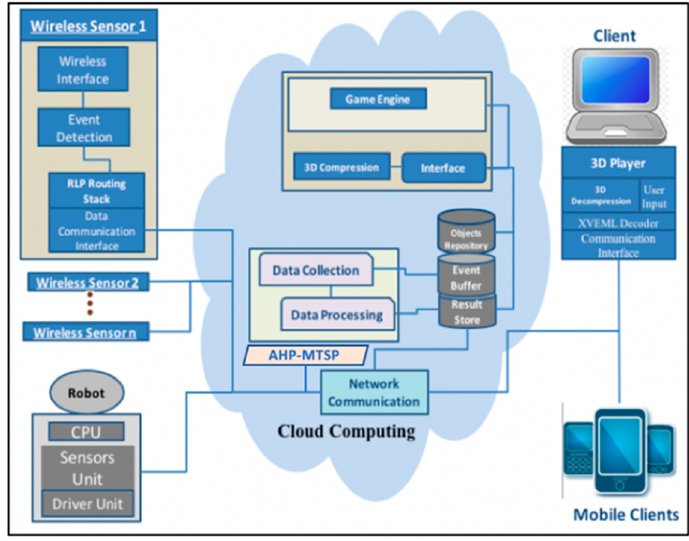
Figure 3. Detailed cloud architecture.